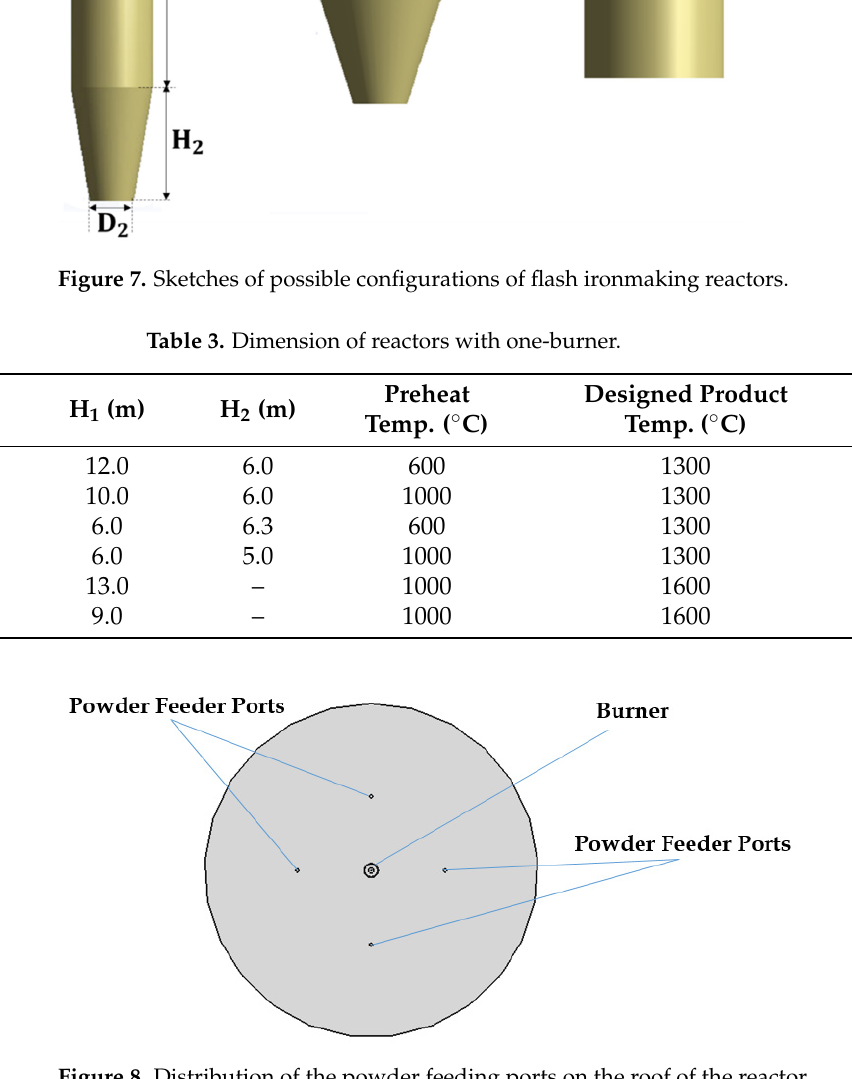
Table 4. Wall material properties. Wall Material